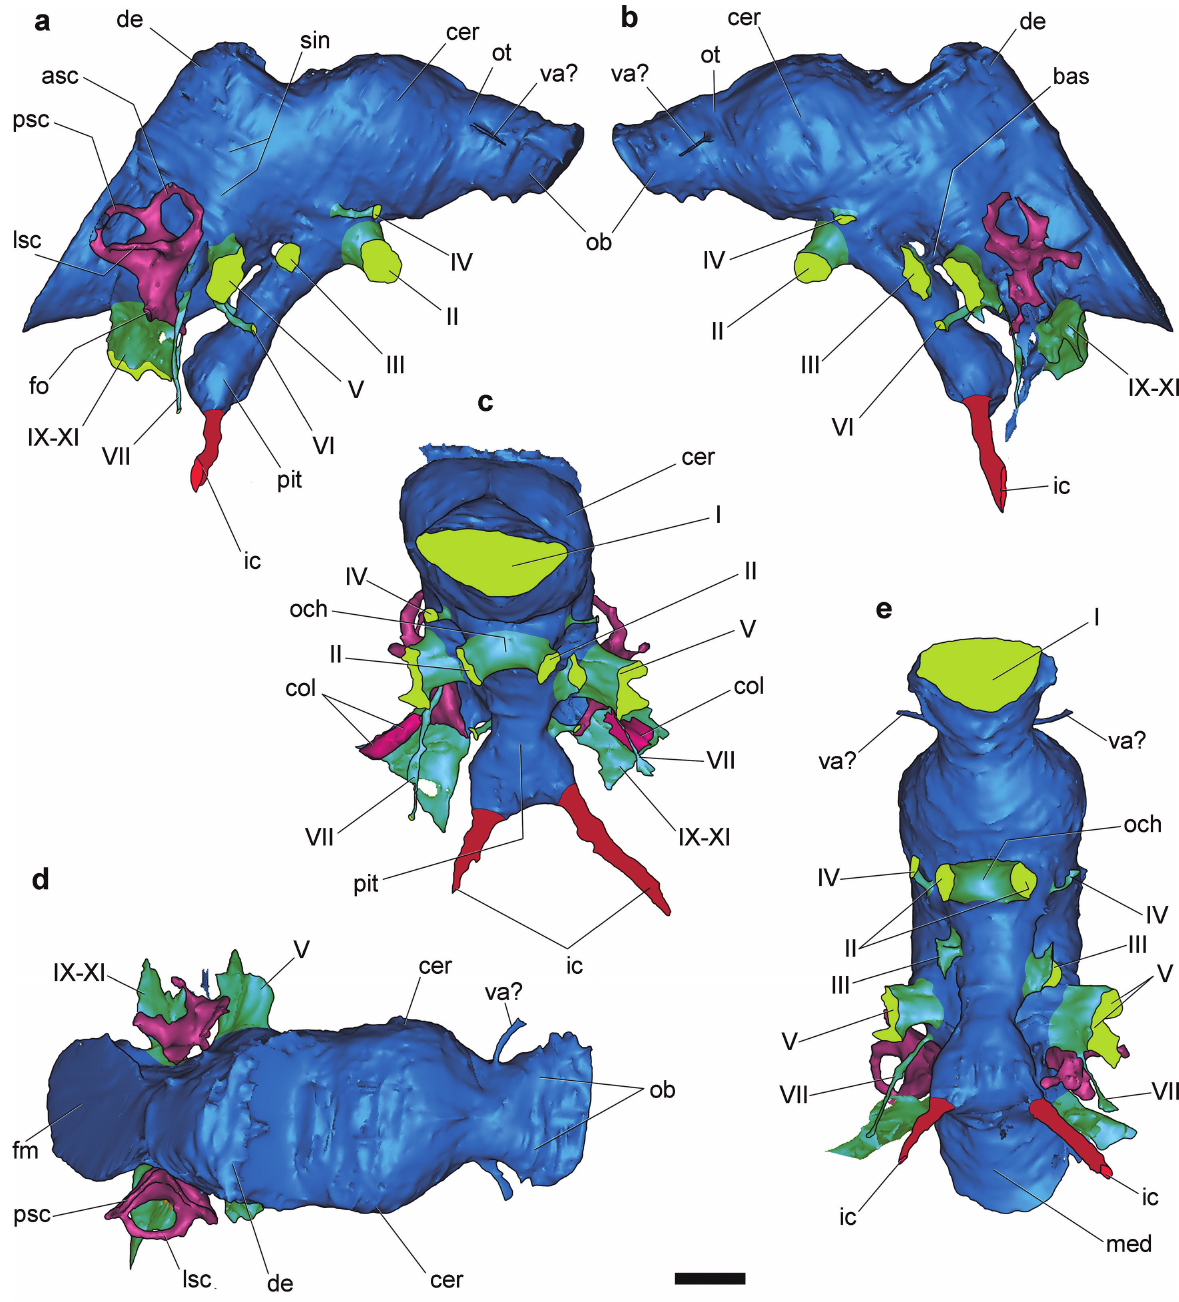
Figure 2. Segmentation of the brain and inner ear of Limaysaurus tessonei (MUCPv-205) in a, right; b, left; c, anterior; d, dorsal and e, ventral views. Cranial nerves are in yellow, internal carotid arteries are in red and the cast of the columellar recess (Fig. 3c) is in magenta. Abbreviations: asc, anterior semicircular canal; cer, cerebral med, medulla oblongata hemisphere; de, dorsal expansion; fo, fenestra ovalis; ic, internal carotid artery; lsc, lateral semicircular canal; ob, olfactory bulb; och, optic chiasm; ot, olfactory tract; pit, pituitary; psc, posterior semicircular canal; sin, transversal venous sinus; va, vascular element (unidentified blood vessel); I-XI, cranial nerves. Scale bar= 10